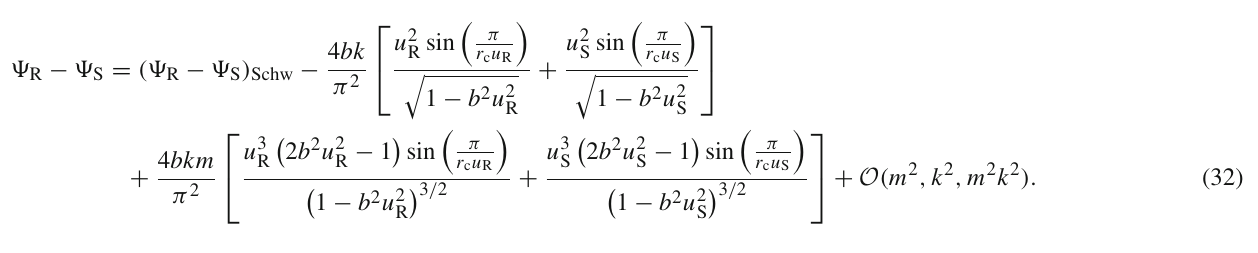
IntheSFDMprofile, theparameters for Sgr. A*arethefol- lowing: ρ c = 3 . 43 × 10 7 M (cid:6) kpc − 3 and r c = 15 . 7 kpc for